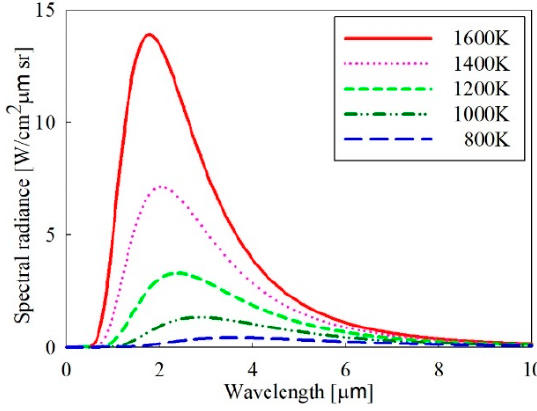
Figure 1. Spectral radiance according to temperature for a black body.